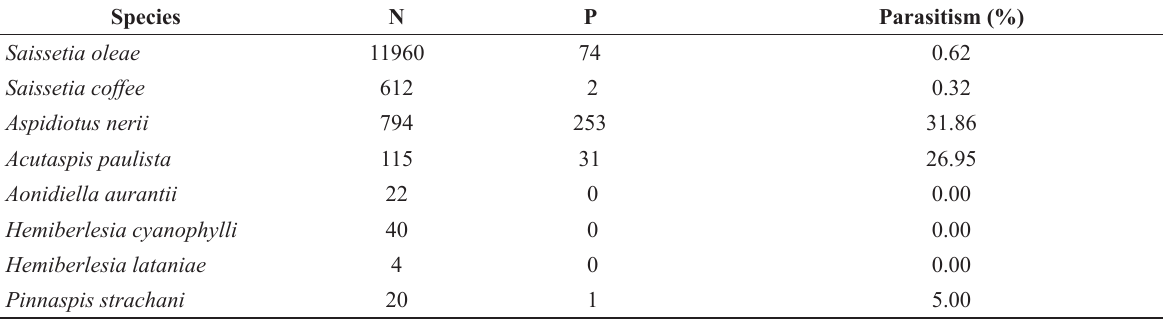
Number of total individuals (N), number of individuals with parasitoid (P), percentage of parasitism of scale insect species found in the area of olive trees ( Olea europaea L.) Encruzilhada do Sul, RS, from April 2013 to February 2014. Species N